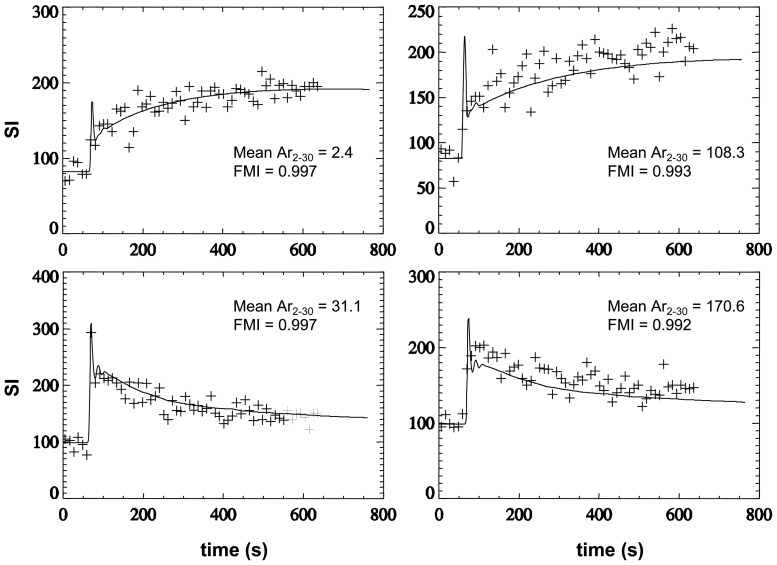
Shows fitting results for Experimental and modelled signal enhancement data SI(t).Experimental data are shown with symbols of “+”. Modeled data are shown as a solid line. The good fits (left column) are characterized by a lower (near zero) ‘Mean Ar2–30’ and a higher fraction of modeling information (FMI) [47], where Ar is the autocorrelation of the residual, and the ‘Mean Ar2–30’ was the mean Ar over the time lags 2 to 30. The poor fits with considerable modeling error (right column) are characterized by a higher ‘Mean Ar2–30’ and a lower FMI.